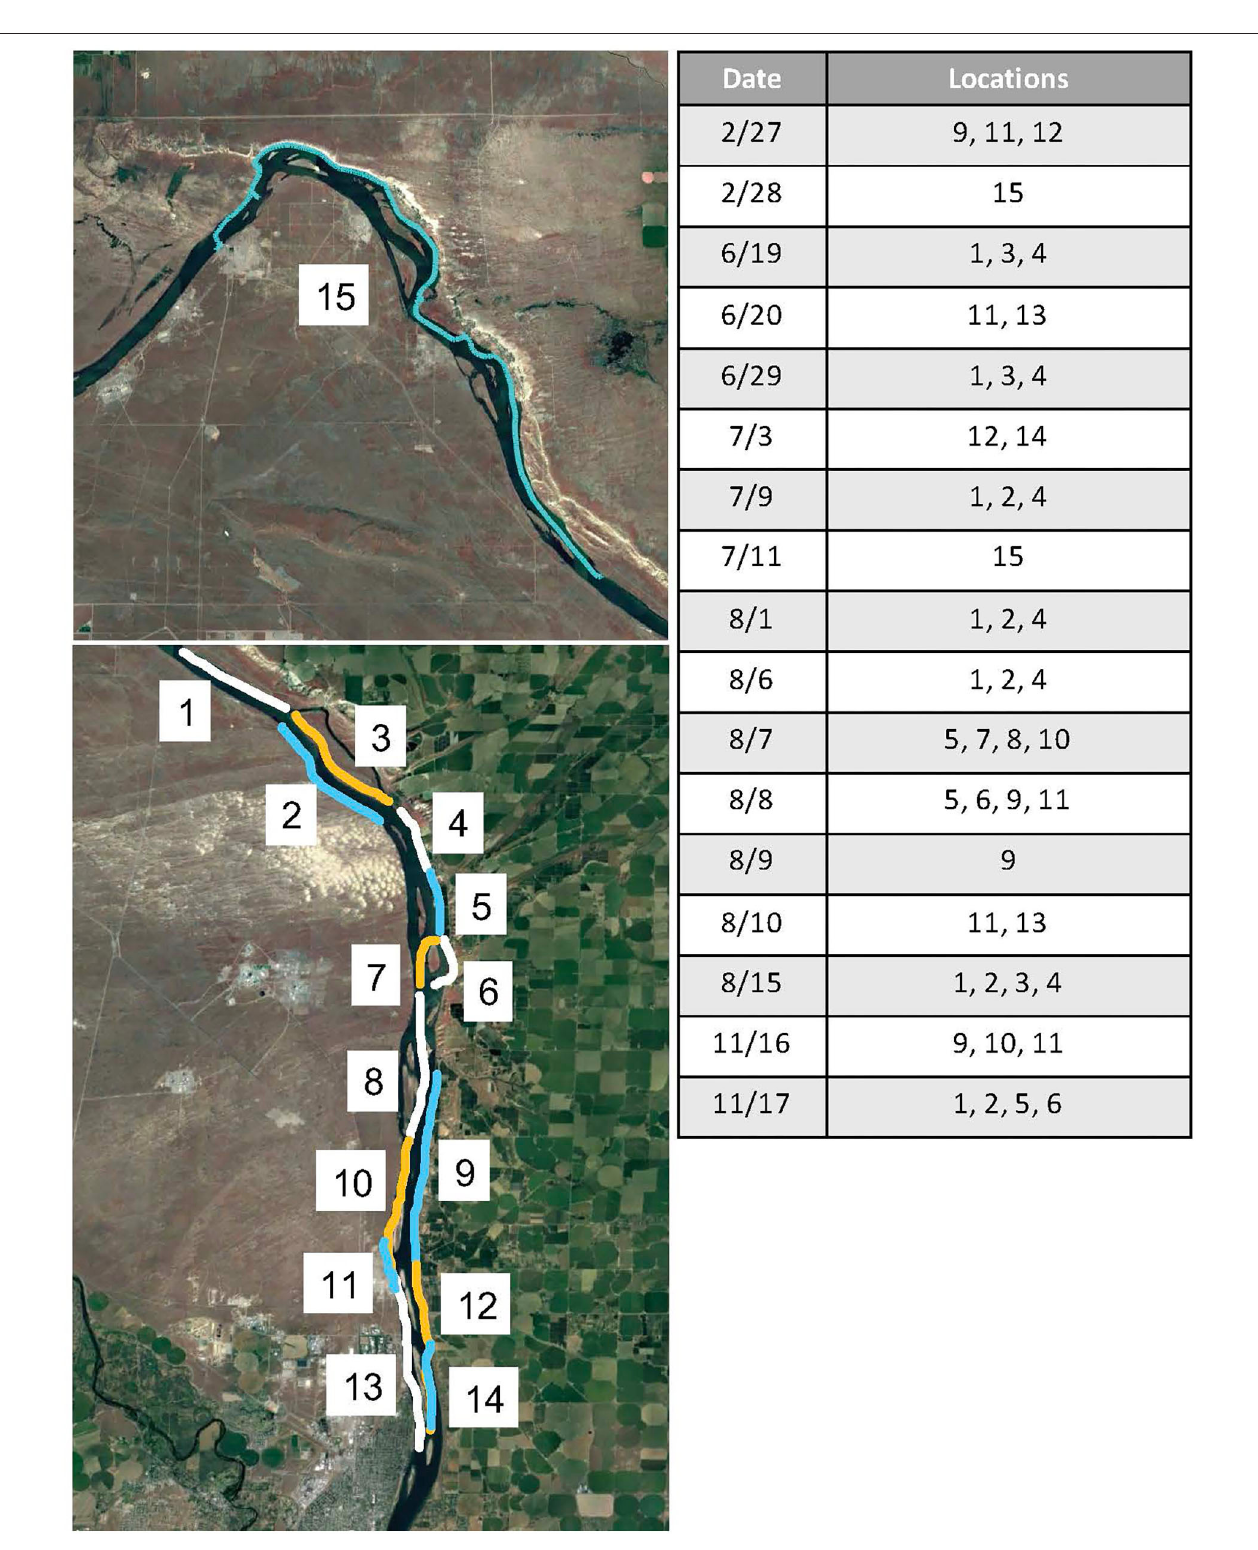
FIGURE 4 | Sampling locations along the Hanford reach of the Columbia River as indicated by section and date (month/date) of 2018. The locations refer to the sections of river as labeled in the map. Each location is numbered, and colors are used to distinguish between sections. Map data from Google, Landsat.